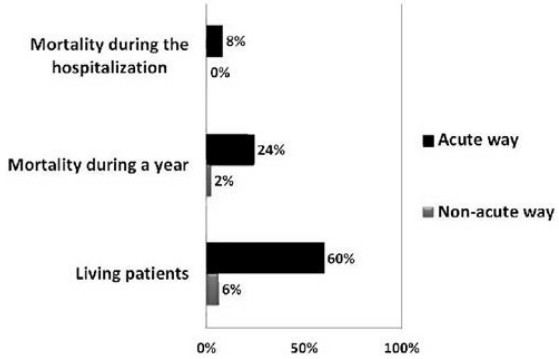
Figure 3. Mortality in groups of patients admitted to hospital in acute versus non-acute way.